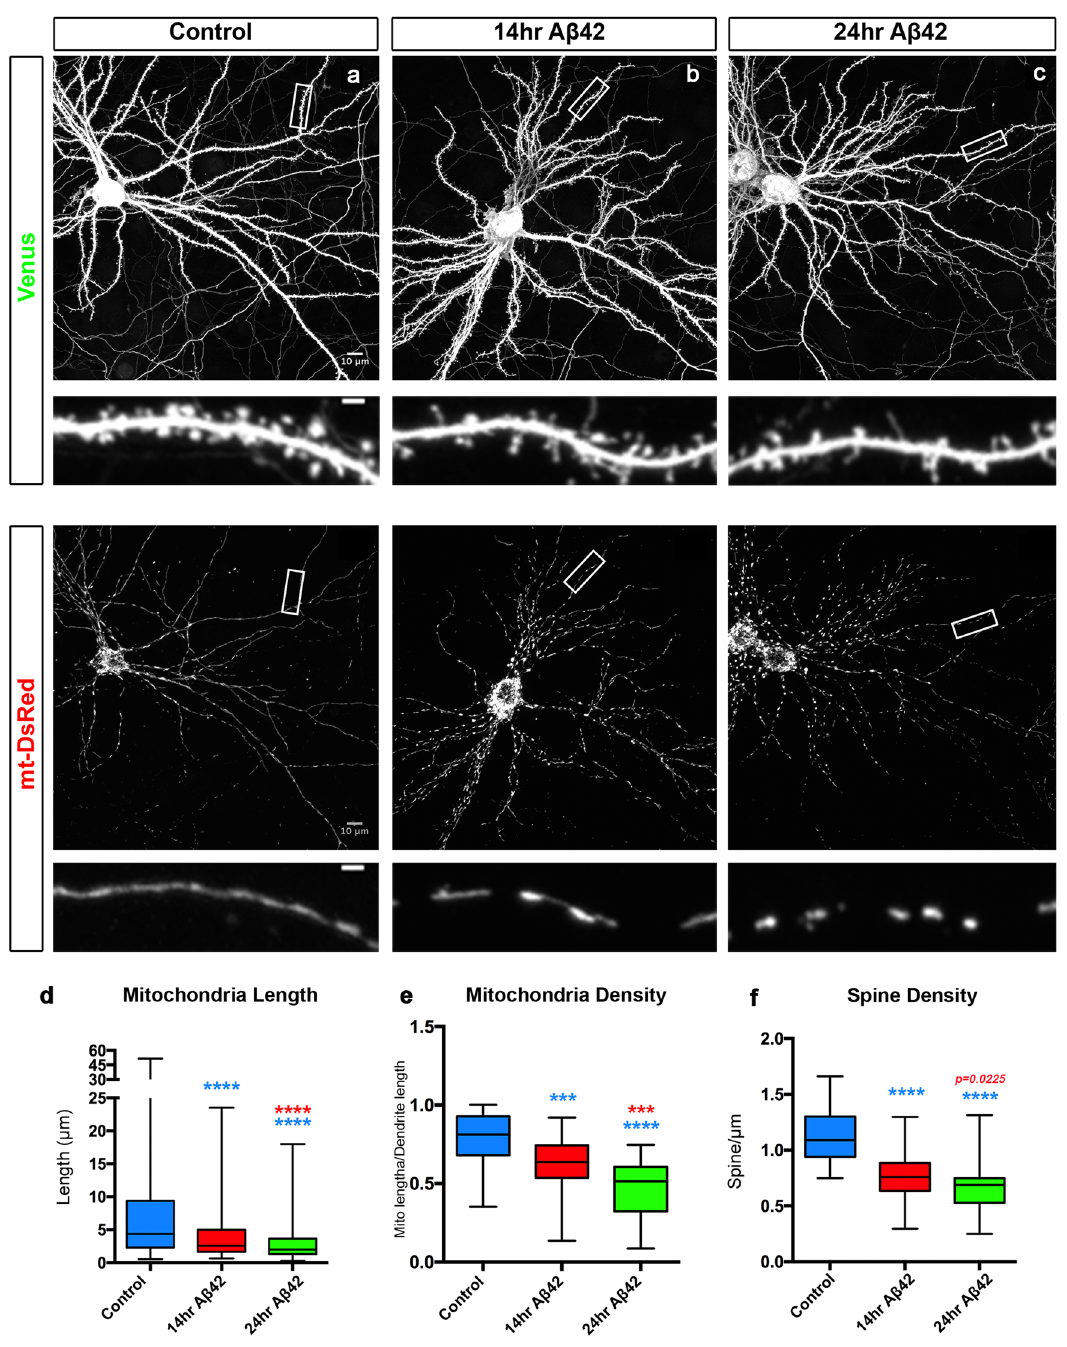
Fig. 2 | A β 42o induces dendritic mitochondrial fragmentation and dendritic spine loss within the same time frame. a – c Representative images of primary cortical neurons at 21 days in vitro (DIV). Neurons express via ex utero electro- porationpCAG-mVenus(upperpanelsin a – c )and pCAG-mito-DsRed(lowerpanels in a – c ) to assess spine density and mitochondrial morphology, respectively. At 20 DIV, neurons were treated with either a vehicle control for 24h or with A β 42o (300 – 450nM,see “ Methods ” fordetails)foreither14or24h.Highmagni fi cationof secondary dendrites is shown below the low magni fi cation of the whole neurons. d Quanti fi cation of dendritic mitochondrial length. e Quanti fi cation of dendritic mitochondrialdensity.Dendriticmitochondrialdensitywascalculatedbysumming the length of all the mitochondria then dividing that cumulative length by the length of the dendritic segment in which the mitochondria were quanti fi ed. f Quanti fi cation of dendritic spine density, calculated by dividing the number of